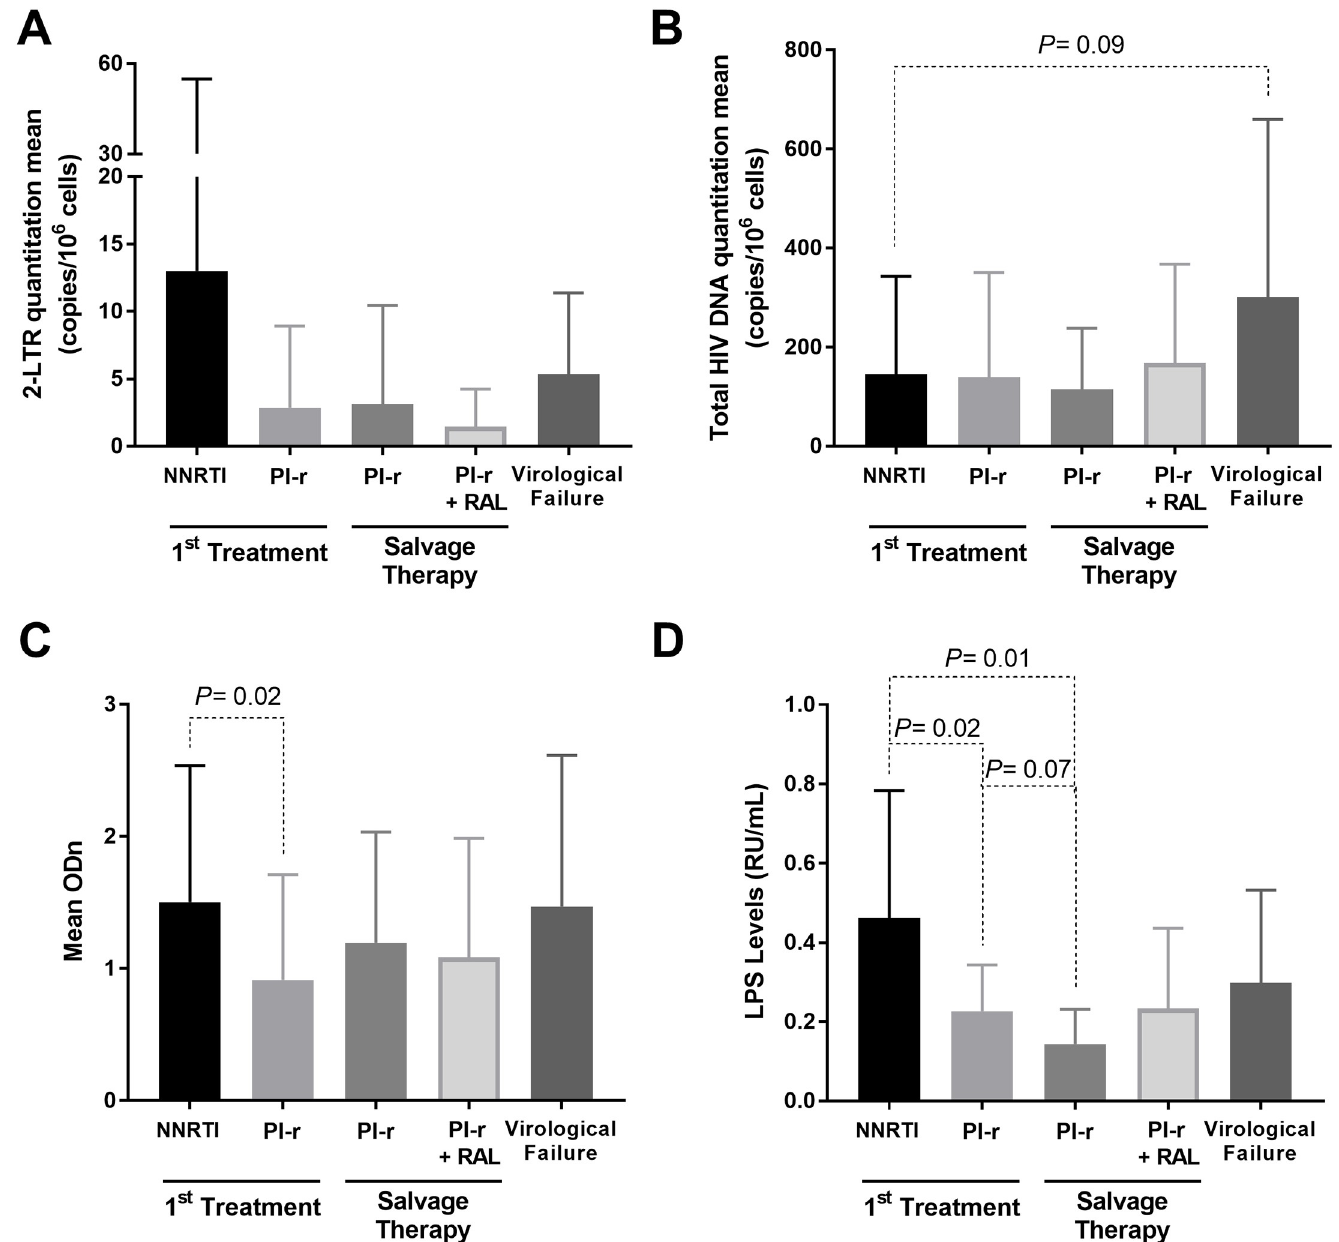
Fig 1. Mean levels of 2-LTR HIV DNA (Panel A), total HIV DNA (Panel B), EIA optical density (ODn; Panel C) and LPS levels (Panel D) among the different treatment groups. Bars show standard deviation. p values lower than 0.1 are indicated.